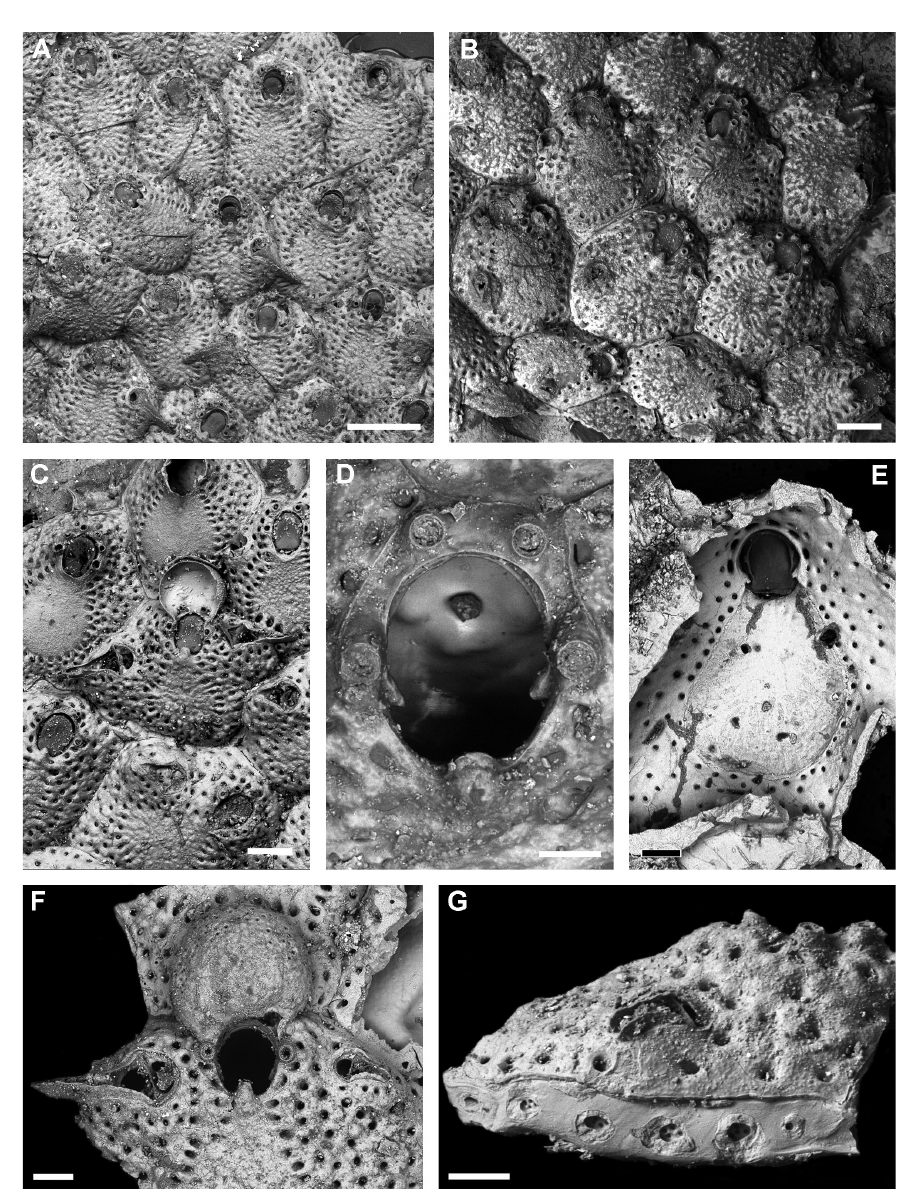
Fig. 3. Hippomenella mucronelliformis (Waters, 1899). A . Overview of autozooids in the lectotype (MM 3780); note the extremely long and slender mandibles of the small avicularia. B . early astogenetic part of the paralectotype (MMF 42297), including the zooid interpreted by Brown (1949) to be the ancestrula (at lower left) but which is here considered as the first autozooid; note that the avicularia in early astogenetic zooids are proximally positioned and directed. C . Autozooids and an ovicellate zooid at the colony margin; note that the forming endooecium is not perforated by pseudopores and that the suboral mucro is absent in early ontogenetic zooids, forming only during later ontogeny (nHMUK 1947.8.12.1; photo: M.e. Spencer Jones). D . Close up of orifice (lectotype, MM 3780). E . interior frontal shield with the umbonuloid ring-scar framed by areolar pores (nHMUK 1947.8.12.1; photo: M.e. Spencer Jones). F . Ovicellate zooid; note the superficial pits on the distolateral endooecium (NHMUK 1947.8.12.1; photo: M.e. Spencer Jones). G . Lateral view of a zooid (distal is to the right), showing five multiporous pore plates in the vertical wall (nHMUK 1947.8.12.1; photo: K.J. Tilbrook). Scale bars: A = 400 µm; B, C = 200 µm; D = 50 µm; e, F, g = 100